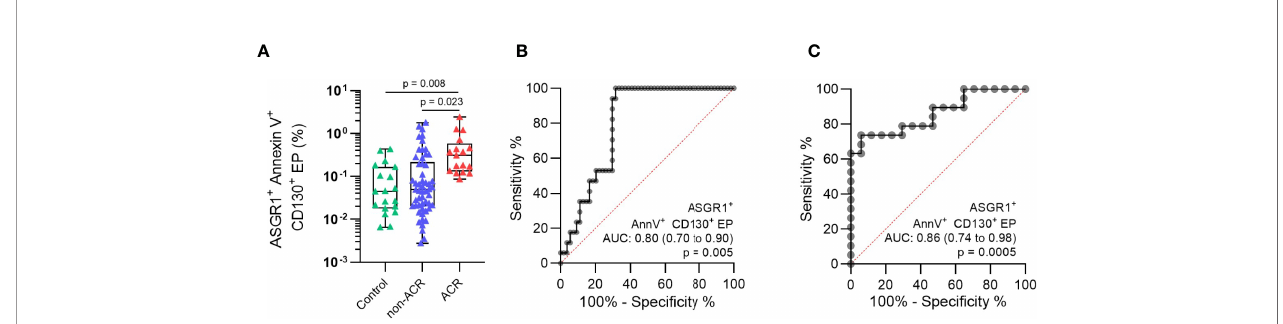
FIGURE 6 | Analysis of ASGR1 + CD130 + AnnV + EP (%) population discovered by viSNE maps and FlowSOM algorithm. (A) The particular EP subpopulation was identi fi ed in the plasma of patients with concomitant LBs. The patients were then classi fi ed as histology-proven ACR or non-ACR. ROC was constructed by comparing (B) ACR vs non-ACR and (C) ACR vs control. One-way analysis of variance followed by Tukey ’ s post hoc test was used. ROC curves and AUC were generated for relative EP. The plots are indicated by the median, and all error bars indicate